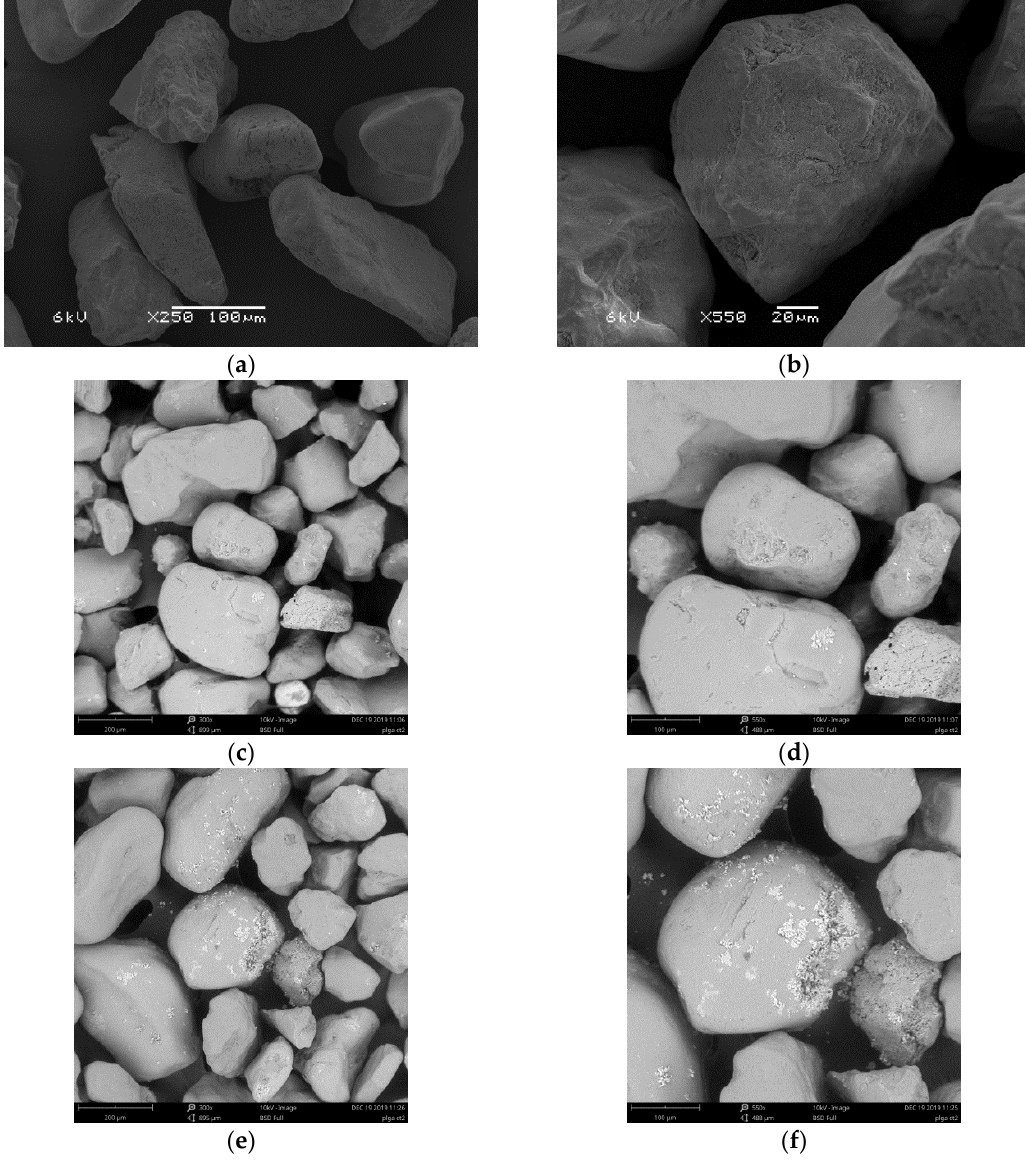
Figure 12. SEM images of the BSF4 top layer of sand in different magnifications. ( a ) Grains on day 0, 250×; ( b ) grains on day 0, 550×; ( c ) grains on day 45 of operation, 300×; ( d ) grains on day 45 of operation, 550×; ( e ) grains on day 90 of operation, 300×; ( f ) grains on day 90 of operation, 550×.